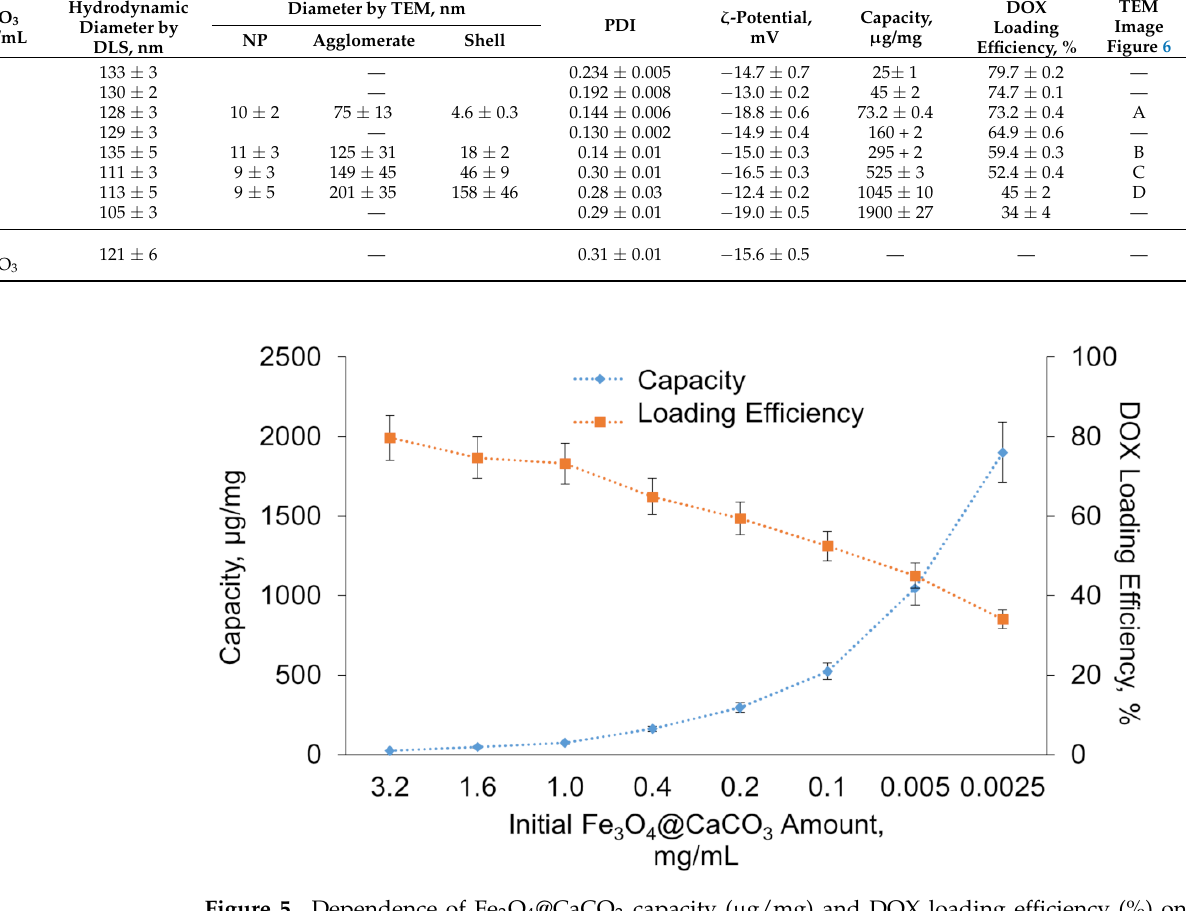
Figure 5. Dependence of Fe 3 O 4 @CaCO 3 capacity ( µ g/mg) and DOX loading efficiency (%) on nanoparticle